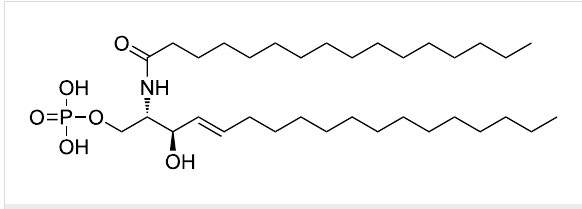
Figure 1: Chemical structure of fully protonated C1P.